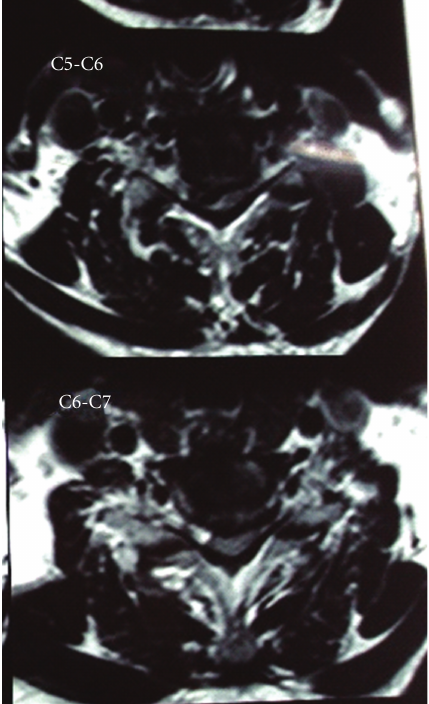
Figure 3: Images showing hemicompression at C5-C6, C6-C7